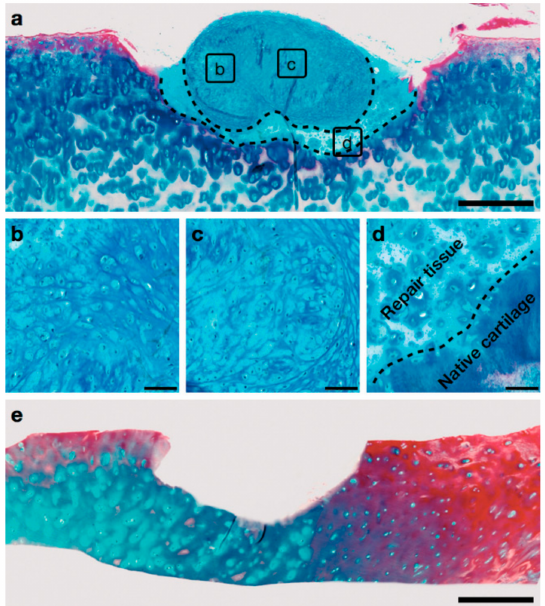
Figure 7. Implantation of an acoustically generated cartilage graft in healthy human tissue with a drilled defect ( a ). Close-ups are shown in ( b , d ), and in particular, ( d ) shows the fusion between the native tissue and the graft with formation of hyaline cartilage in the gap. A defect before implantation is shown in ( e ). The scale bars in ( a , e ) correspond to 500 µ m; whereas the scale bars in ( b , d ) correspond to 50 µ m. Reprinted from [63] published by the Royal Society of